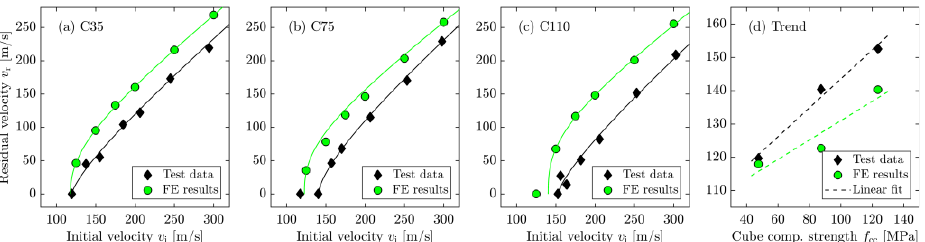
Fig. 3. Time lapse from high-speed camera images of ballistic impact tests for test C35-9 (left column), C75-7 (centre) and C110-8 (right).